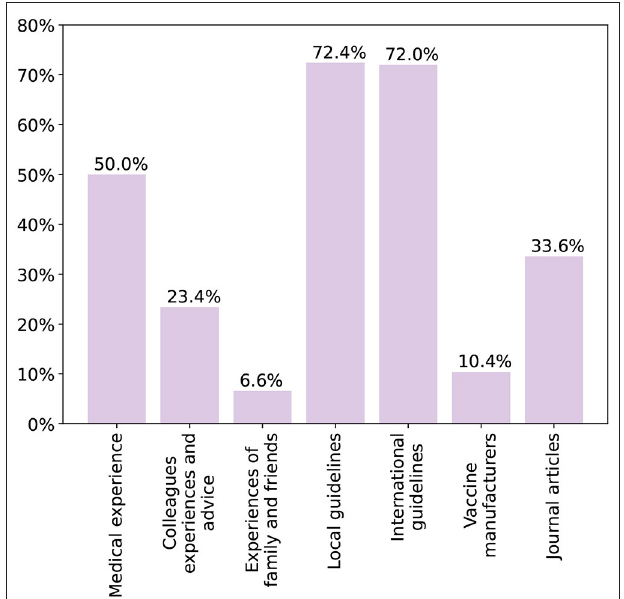
FIGURE 2 | Main sources of knowledge of participating physicians.